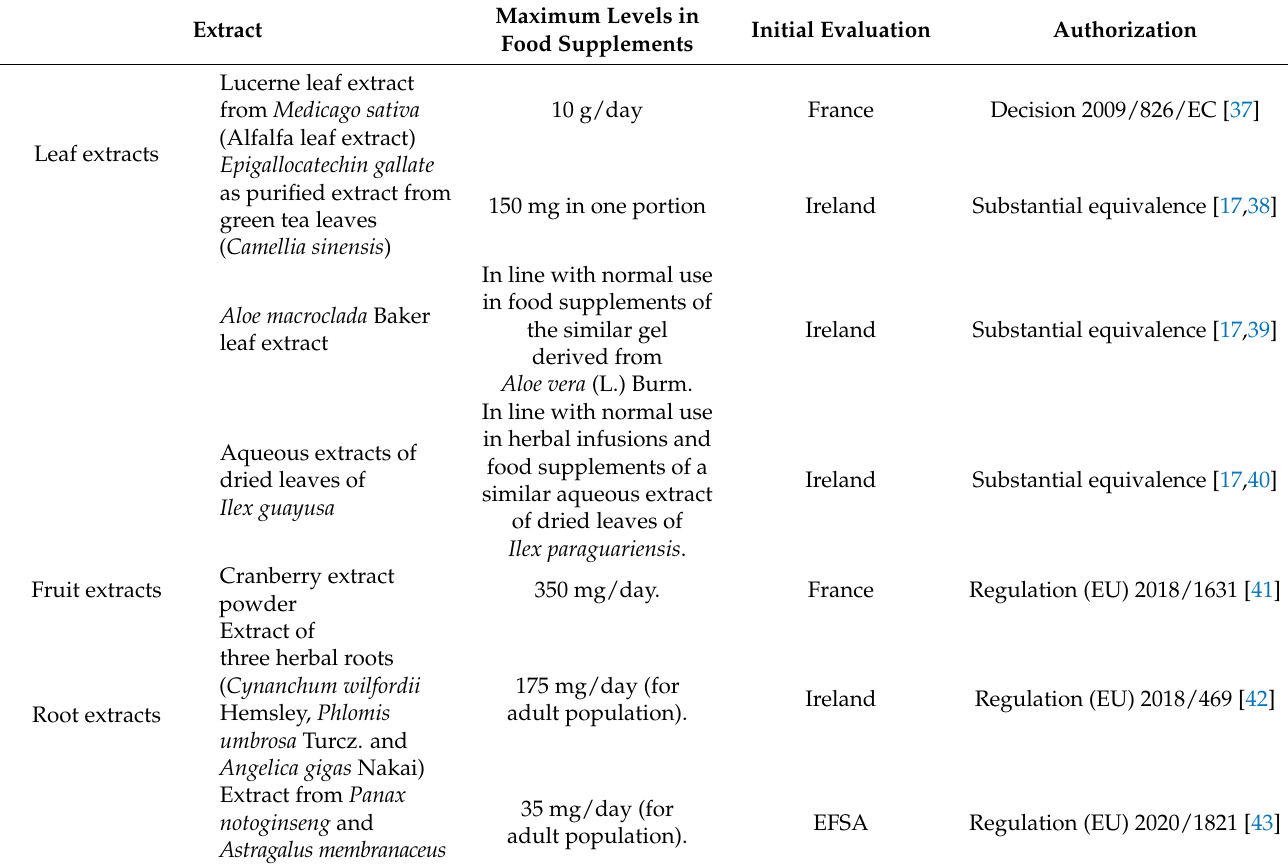
Table 2. Leaf, fruit, and root extracts authorized as novel foods for its use in food